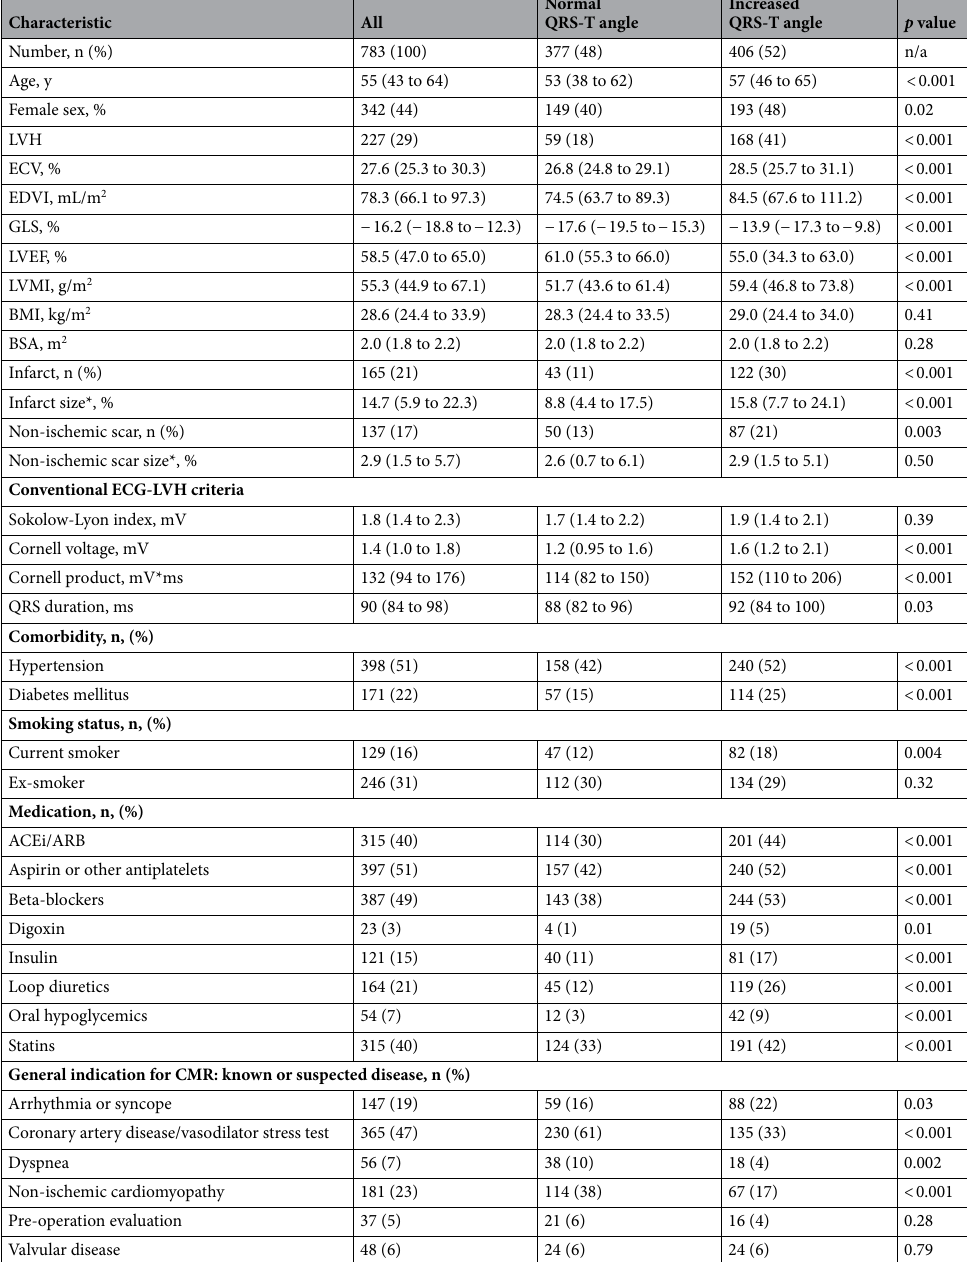
Table 1. Baseline characteristics for the Clinical-Consecutive cohort. Continuous data are given as median (interquartile interval), or number (%), and compared between the Normal QRS-T angle group and Increased QRS-T angle groups using Mann–Whitney U test or Chi-square, respectively. ACEi Angiotensin-converting enzyme inhibitors, ARB Angiotensin II receptor blocker, BMI Body mass index, BSA Body surface area, CMR Cardiovascular magnetic resonance imaging, ECV Extracellular volume fraction, LVEDVI Left ventricular end-diastolic volume index, GLS Global longitudinal strain, LVEF Left ventricular ejection fraction, LVMI Left ventricular mass index. *Denotes that the descriptive data are presented only for those patients with infarct or non-ischemic scar,